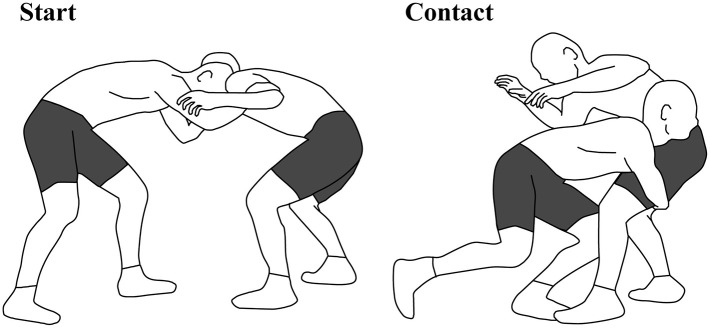
Schematic diagram of a double-leg attack from the starting position (left) to the ending position (right).